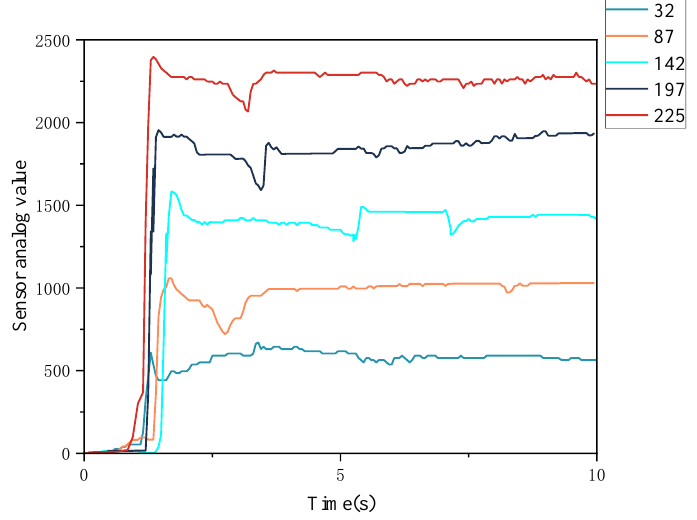
Figure 8. Relationship between tactile stimulus intensity and sensor feedback value.